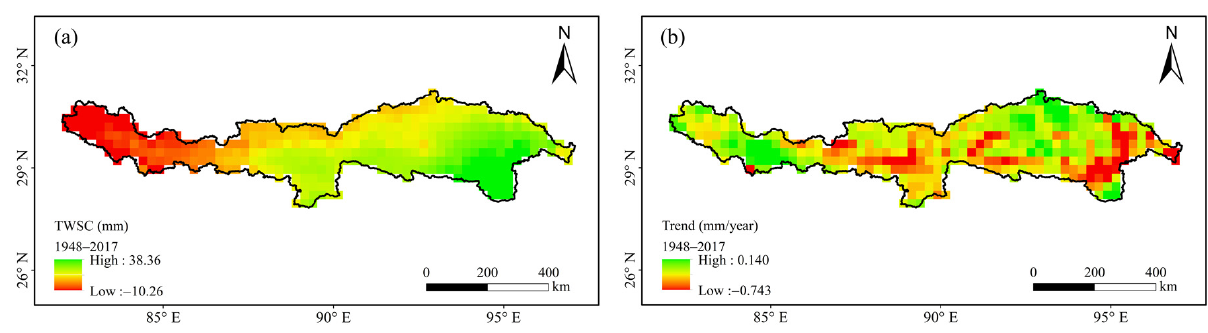
Figure 7. Spatial distribution of multi-year average value of TWSC ( a ) and variation trend of multi-year average of TWSC ( b ) in the YZRB from 1948 to 2017.